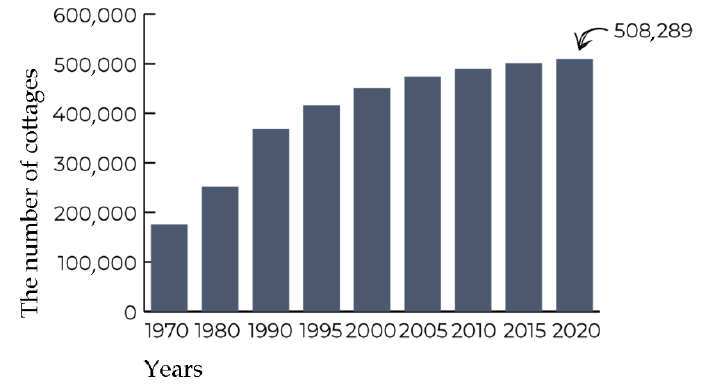
Figure 4. The number of cottages in Finland (1970–2020).